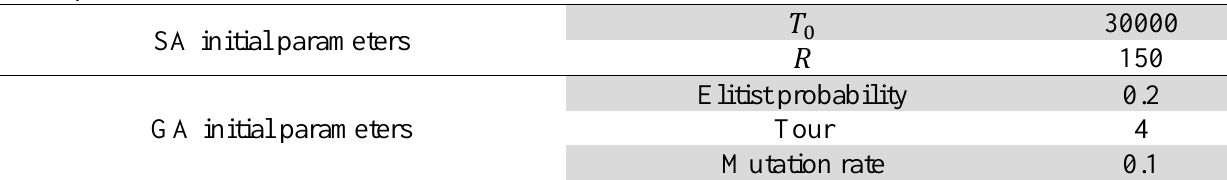
Initial parameter values of SA and GA for RSM